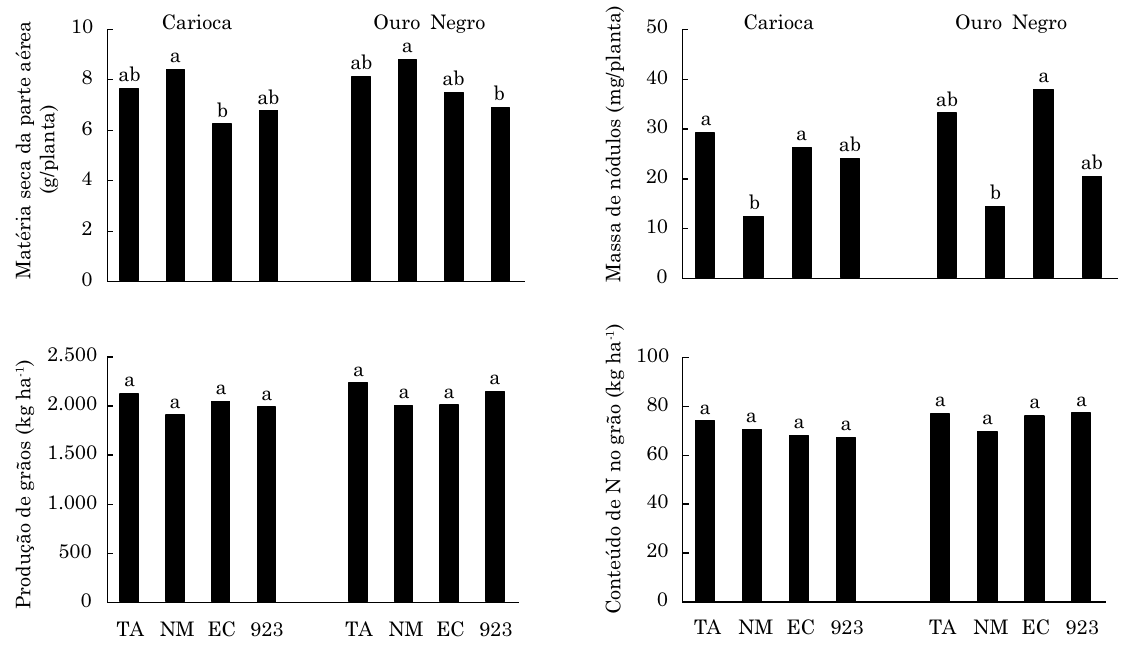
Figura 1. Produção de matéria seca da parte aérea e matéria seca de nódulos quando da floração, da produção de grãos e do conteúdo de N acumulado nos grãos na maturação, das cultivares de feijoeiro comum Carioca e Ouro Negro, no experimento Goiás I, sem adubação nitrogenada (TA - testemunha absoluta) e três fontes de N: NM- testemunha nitrogenada (80 kg ha -1 de N no plantio e 40 kg ha -1 de N em cobertura), EC - inoculação com estirpes comerciais de rizóbio (BR 322 + BR 520 + BR 534) e 923 - inoculação com a estirpe BR 923 de rizóbio. Barras sobrepostas pela mesma letra, dentro de cada cultivar, indicam que médias não diferem pelo teste de Duncan a 5 %. Coeficientes de variação experimental: produção de parte aérea - 18,6 %; massa de nódulos - 40,3 %; e produção de grãos - 18,1